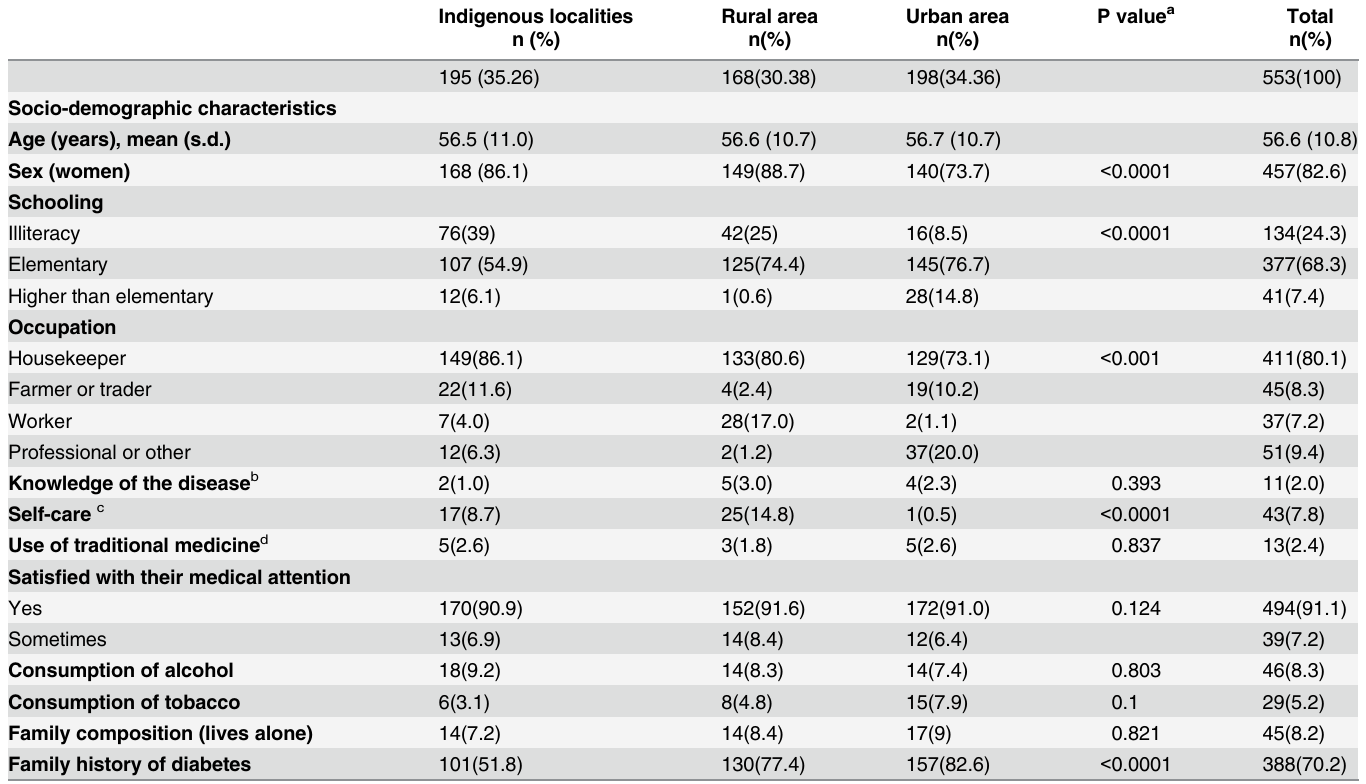
Table 1. Sociodemographic characteristics and behavior of interviewed patients according to